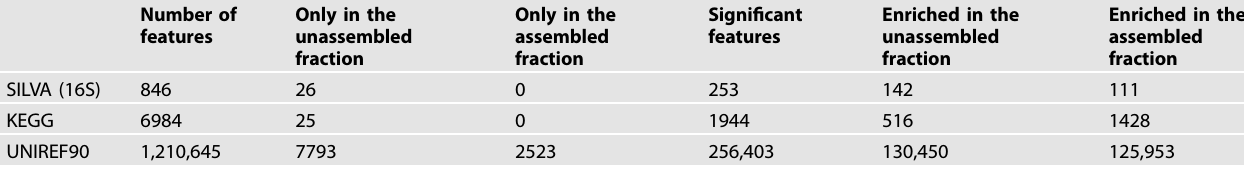
Table 1. Distribution of the SILVA, UNIREF90 and KEGG clusters among the mapped and unmapped reads. Number of